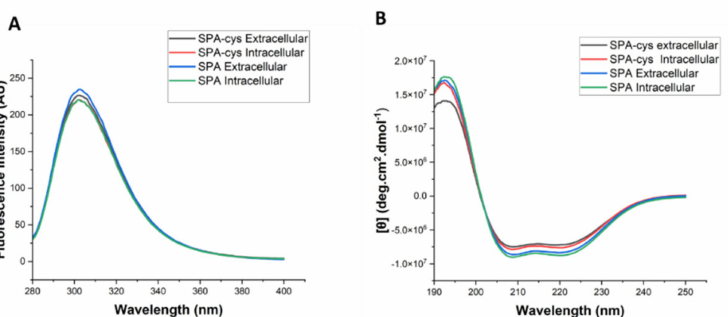
Figure 5. ( A ) Fluorescence emission spectra of SPA-cys intracellular (red), SPA-cys extracellular (black), SPA intracellular (green) and SPA extracellular (blue) in 10 mM phosphate buffer, pH 7.5. ( B ) CD spectra of SPA-cys intracellular (red), SPA-cys extracellular (black), SPA intracellular (green), and SPA extracellular (blue) in 10 mM phosphate buffer, pH